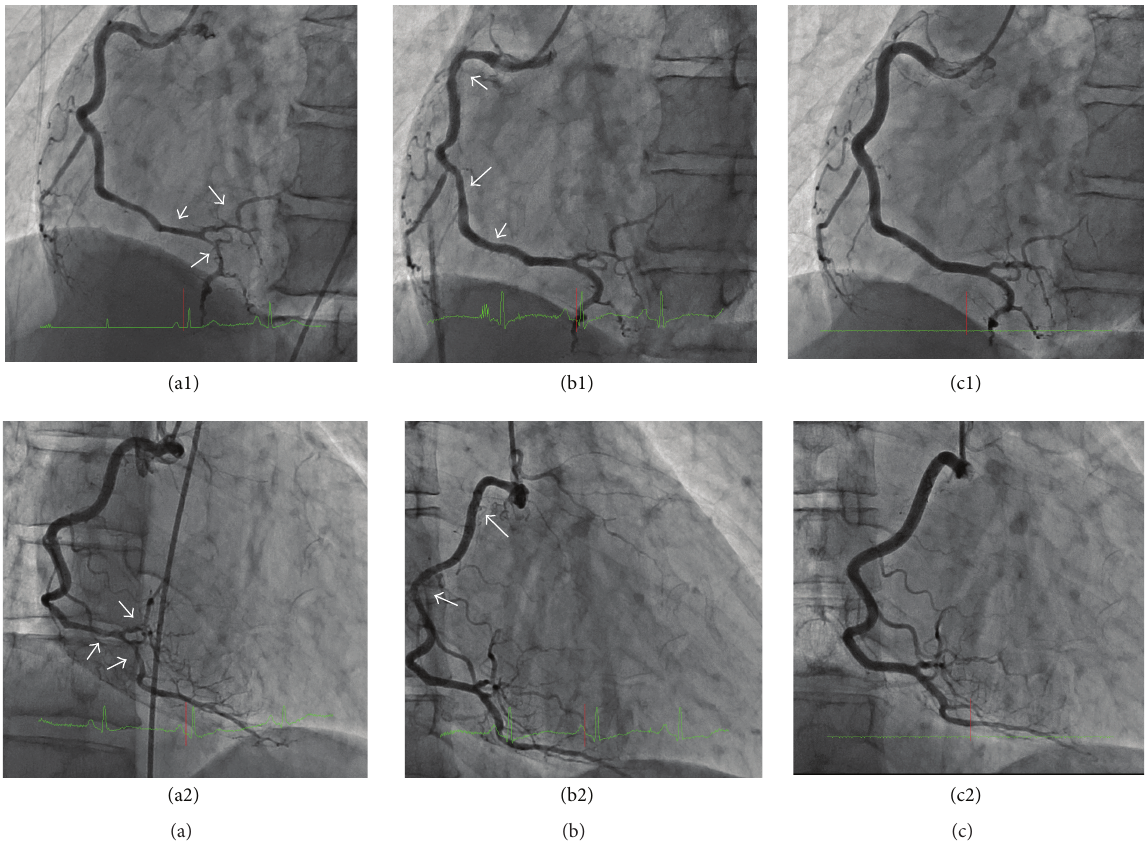
Figure 1: Time course of a coronary angiogram of the right coronary artery (RCA). (a) MI onset; (b) 12 days after the onset of the MI; (c) 6 months after the onset of the MI. 1: LAO view; 2: RAO